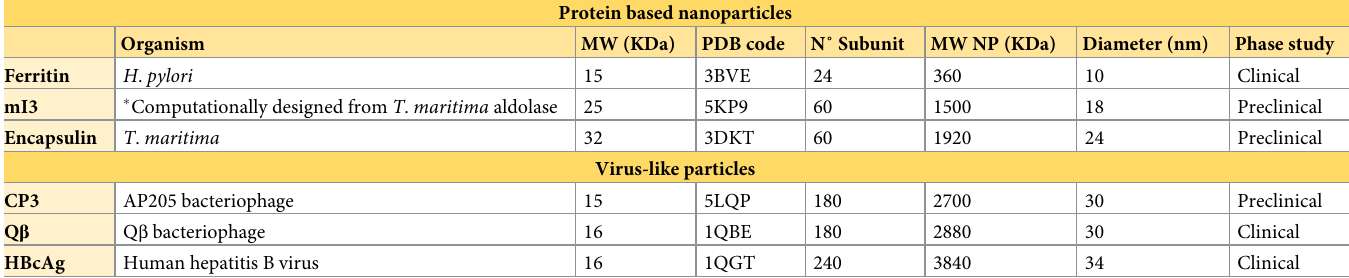
Table 1. Summary of protein-based nanoparticles and virus like particles tested in this study.